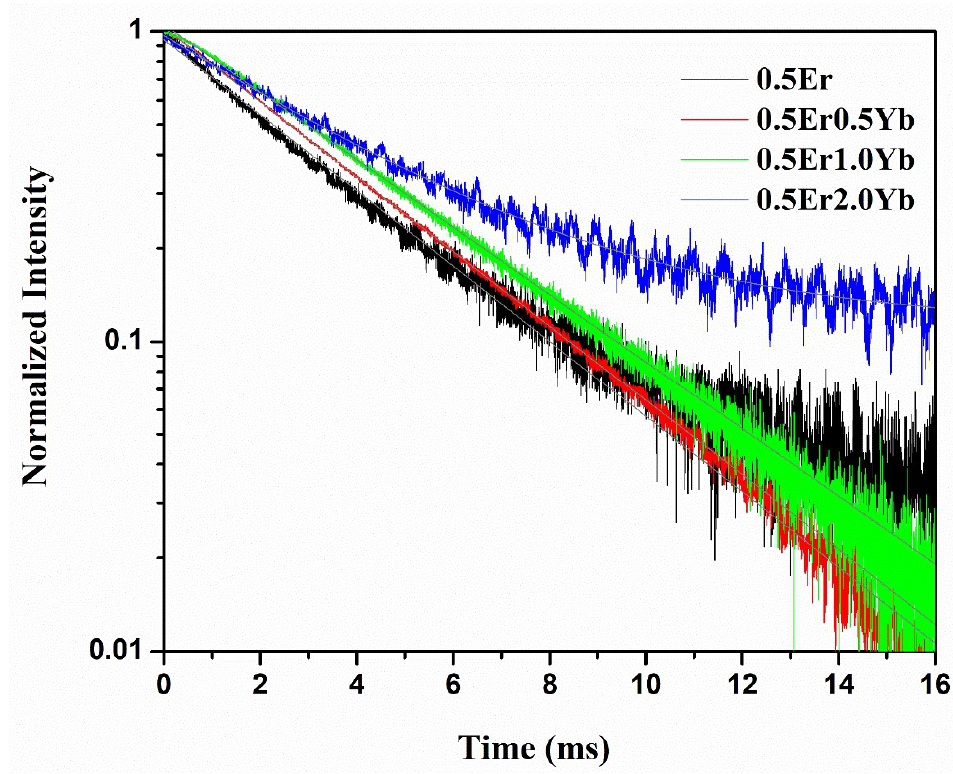
Figure 10. Decay profiles of 4 I 13/2 → 4 I 15/2 transition of 0.5Er and Er 3+ /Yb 3+ co-doped ZBB